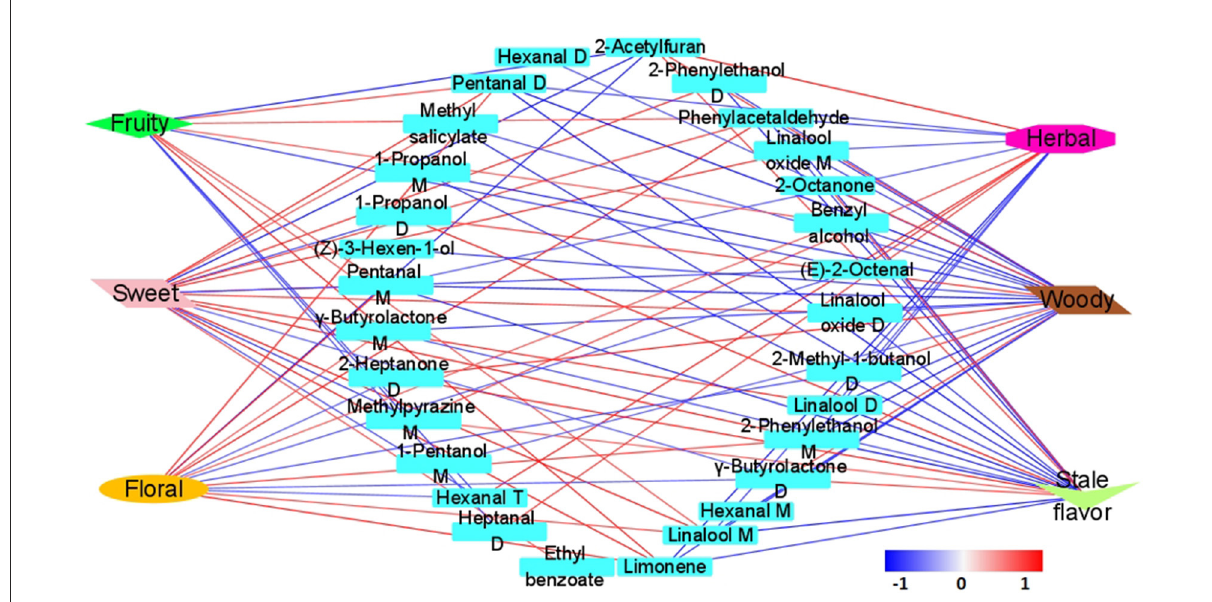
FIGURE6 Correlation network diagram of aroma sub-attributes and key aroma components. Blue represented a significant negative correlation, red represented a significant positive correlation ( P < 0.05), and the darker the color, the greater the correlation.